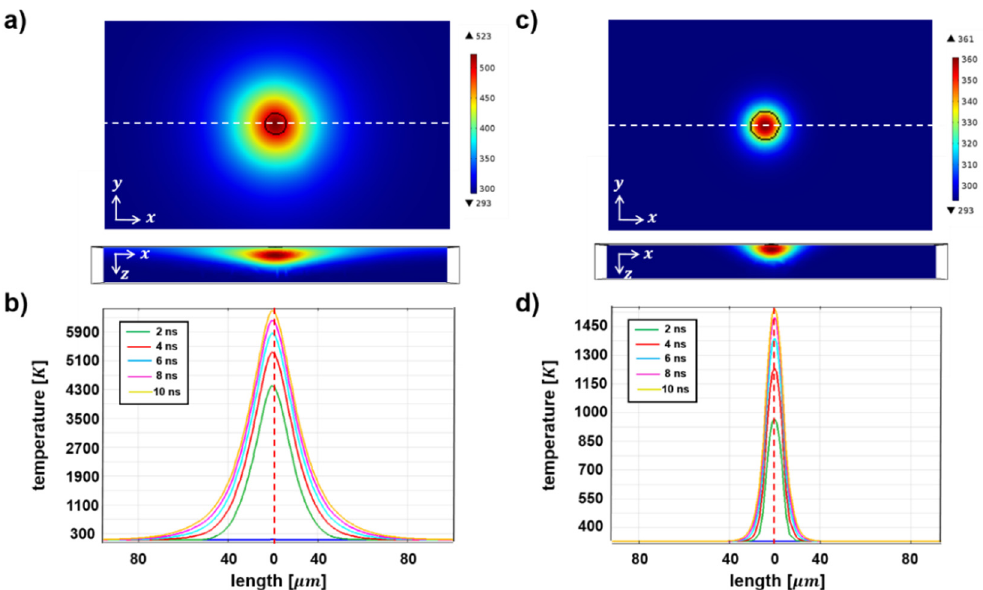
Figure 6. Transient analysis of temperature distribution on ( a , b ) graphene / ITO double layers and ( c , d ) ITO single layers, enabled by laser-beam irradiation. The two-dimensional features of instant temperature profiles with heating by laser-beam irradiation for 10 ns are shown in the x–y and x–z planes ( top ), and the corresponding transient temperature changes along the white dotted line are presented for every 2 ns ( bottom ).